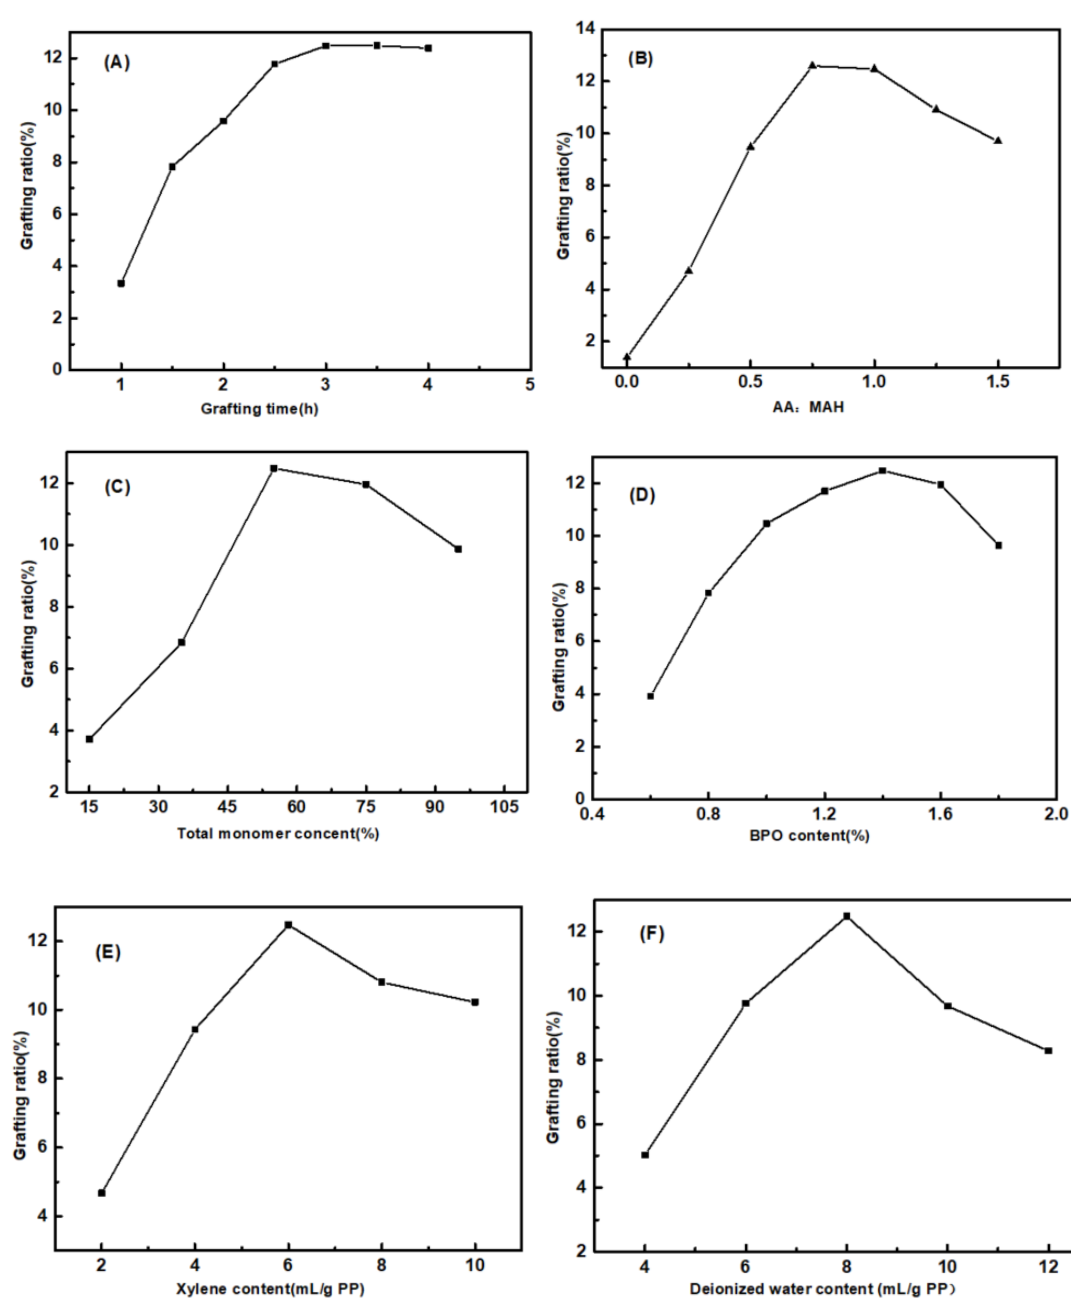
Figure 5. E ff ects of grafting time ( A ), AA / MAH ratio ( B ), total monomer content ( C ), and the dosages Figure 5. Effects of grafting time ( A ), AA/MAH ratio ( B ), total monomer content ( C ), and the dosages of BPO ( D ), xylene ( E ), and deionized water ( F ) on grafting of BPO ( D ), xylene ( E ), and deionized water ( F ) on grafting ratio.